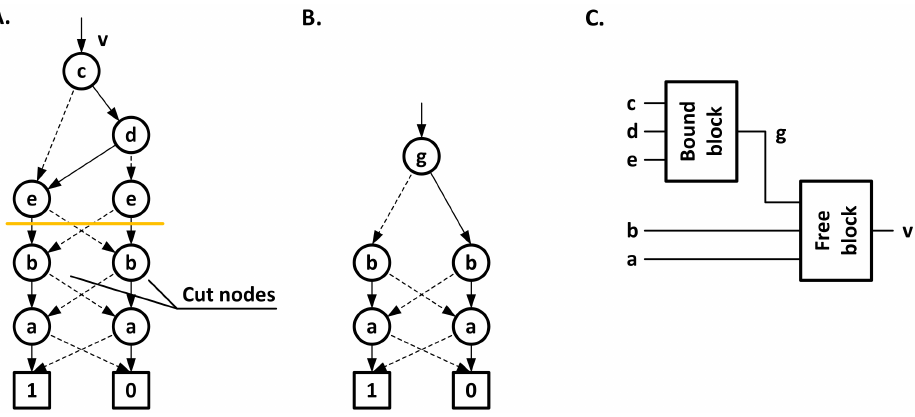
Figure 10. The decomposition of BDD, using horizontal cut line ( A ), free function BDD ( B ), and respective mapping ( C